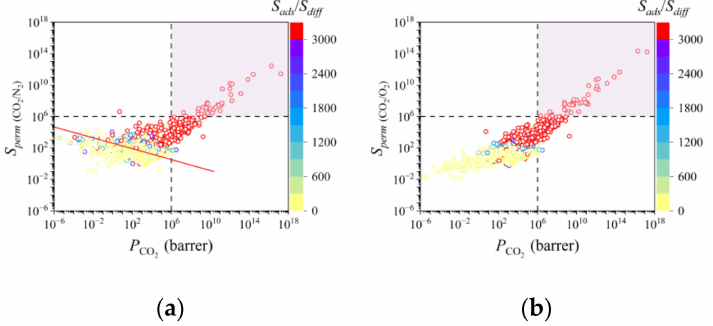
Figure 3. Relationship between P , S perm , and S ads / S diff . ( a ) P CO (CO 2 /N 2 ) ; ( b ) P CO 2 – S perm (CO 2 /O 2 ) – S ads (CO 2 /O 2 ) / S diff (CO 2 /O 2 ) . In ( a ), the red line represents the 2008 Robeson upper